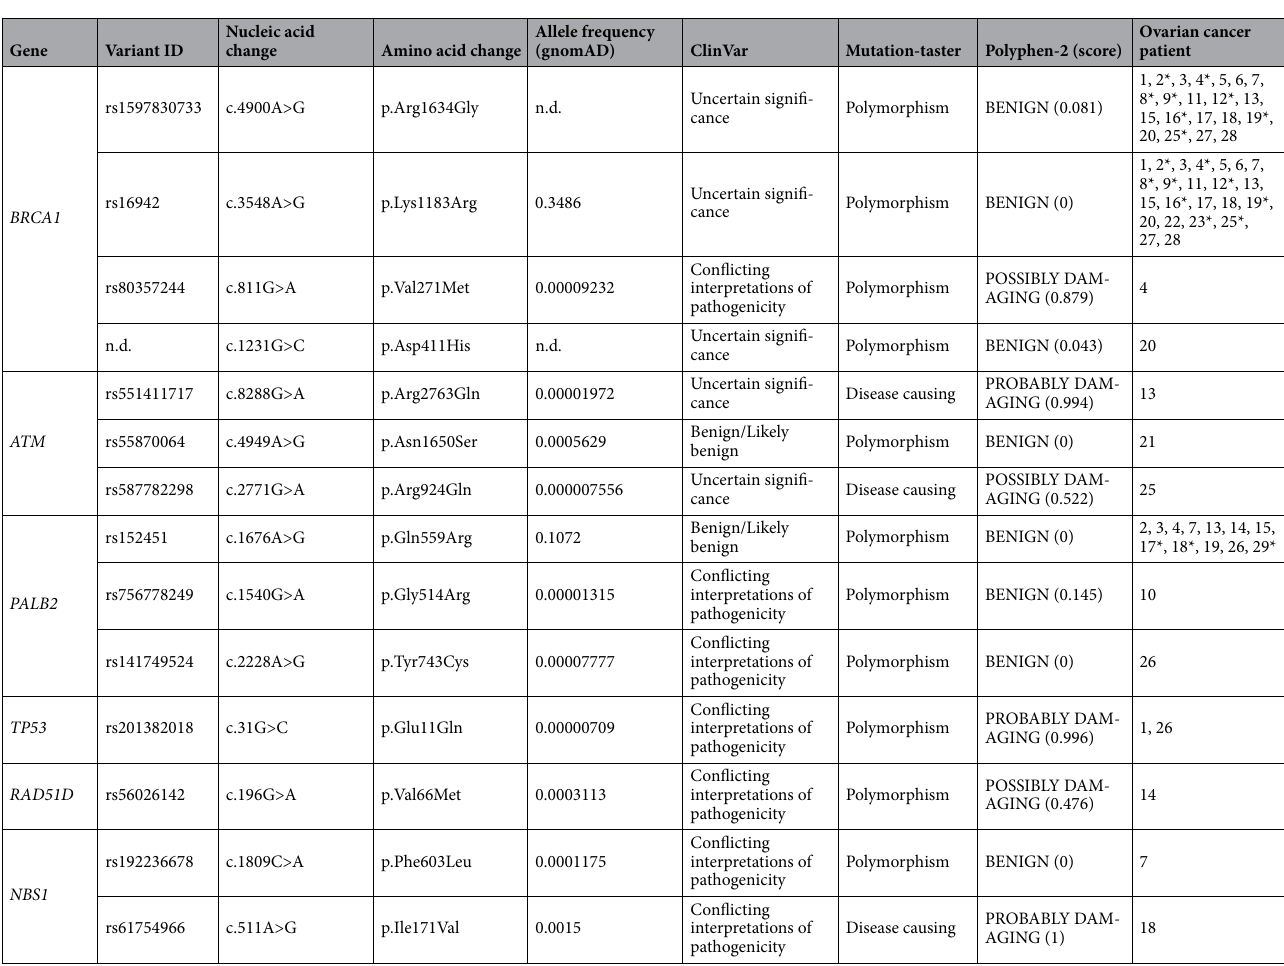
Table 2. Missense variants in the HBOC core gene identified by whole-exome sequencing in 29 ovarian cancer patients. Asterisks indicate homozygosity of the variants. Variants with a “benign” status as evaluated in the ClinVar database are not included in this